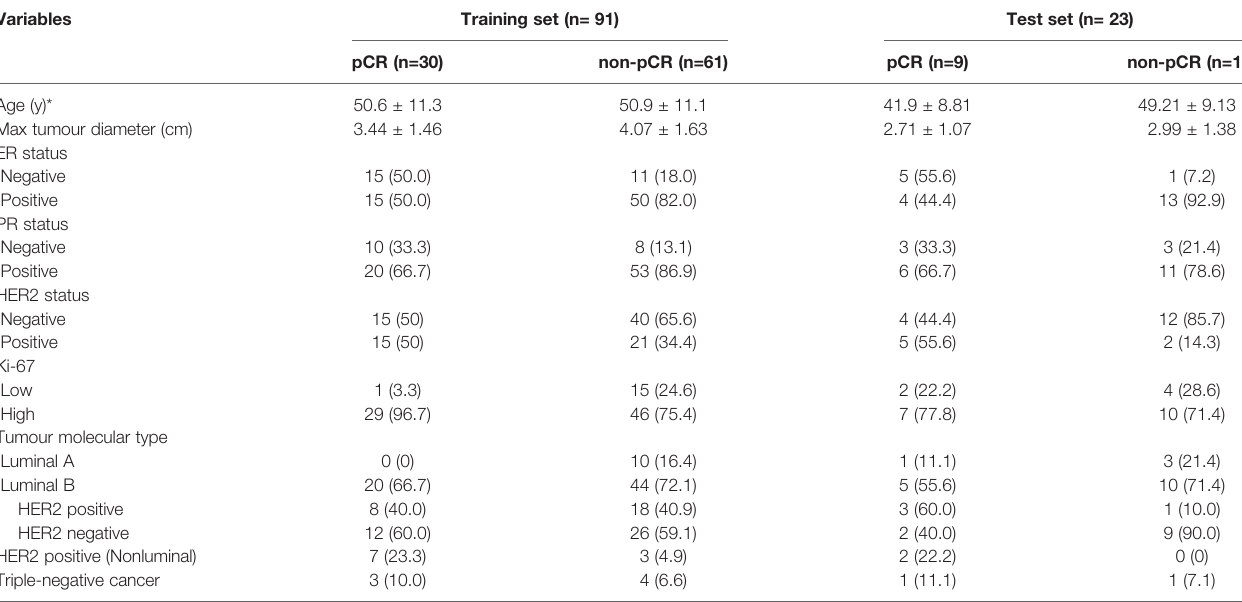
TABLE 4 | Clinical characteristics of the training and test sets containing pCR and non-pCR breast cancer patient data. Variables